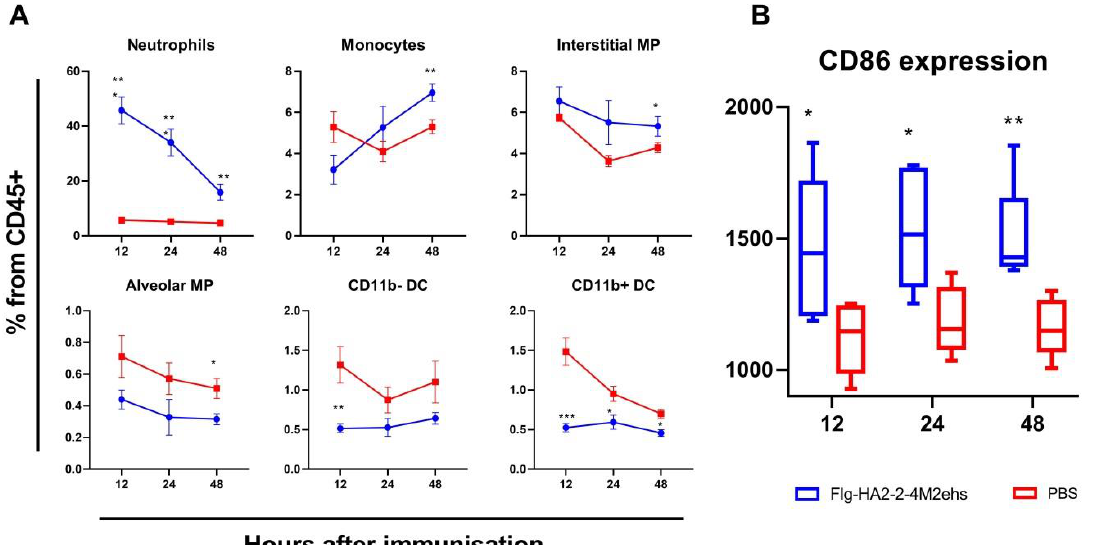
Figure 1. Factors of innate immunity of the lungs of the mice in the early stages (12, 24, 48 h) after intranasal immunization with the chimeric protein Flg-HA2-2-4M2ehs. ( A ) The dynamics of the relative composition of the main populations of innate immunity cells in the lungs of mice at different times after immunization. The graphs show the proportion of different cell populations from the total number of CD45+ cells. ( B ) The dynamics of expression of the CD86 marker in the lungs of mice. The graph shows the values of the median fluorescence intensity (MFI). Significant differences from the control group are marked with * (*: p < 0.05; **: p < 0.01; ***: p < 0.001). The statistical analysis was performed using Student ’ s t -test.